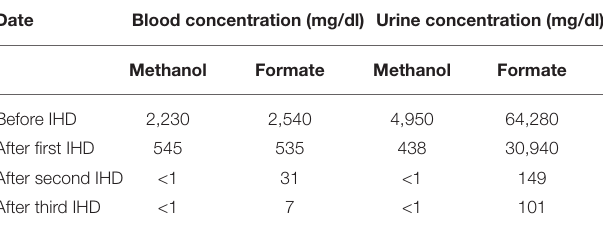
TABLE 1 | The methanol and formate concentration change in blood and